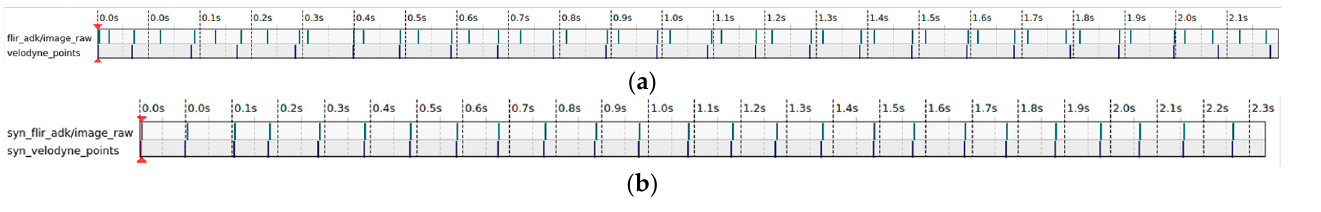
Table 2. Comparative experimental results of different obstacle detection